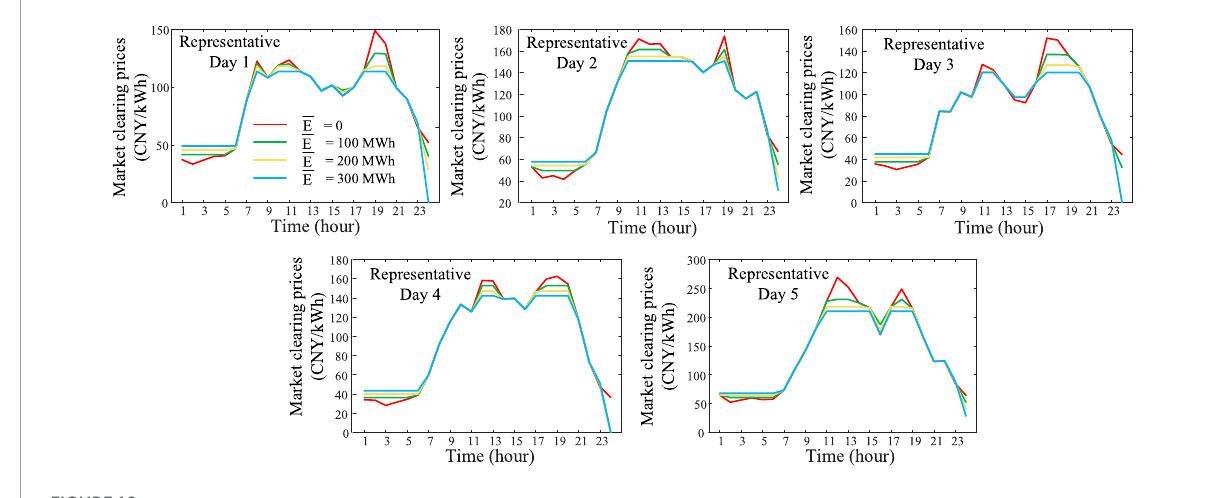
FIGURE 10 Impact of different ES energy capacity scenarios on hourly market clearing prices.